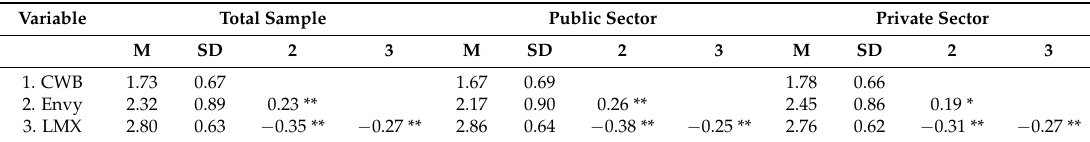
Table 2. Descriptive Statistics and Bivariate Correlations.